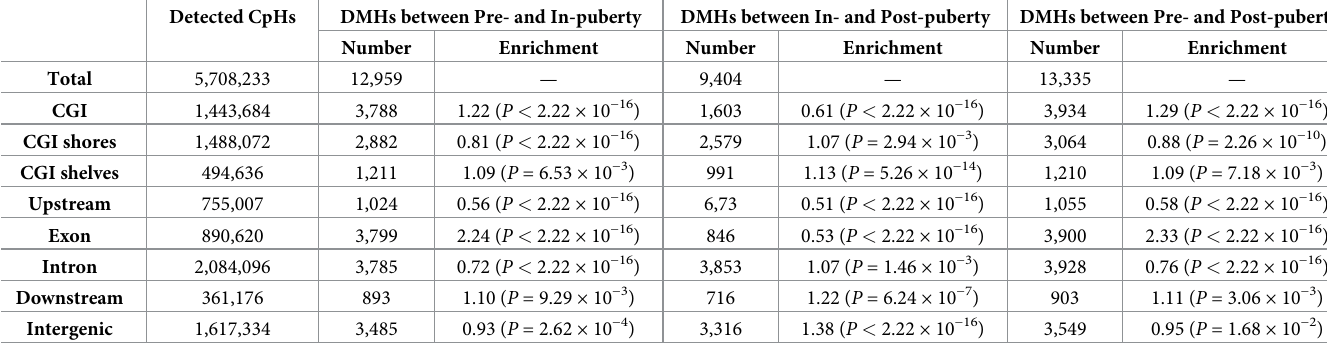
Table 2. Distribution of differentially methylated CpHs among these pituitaries.